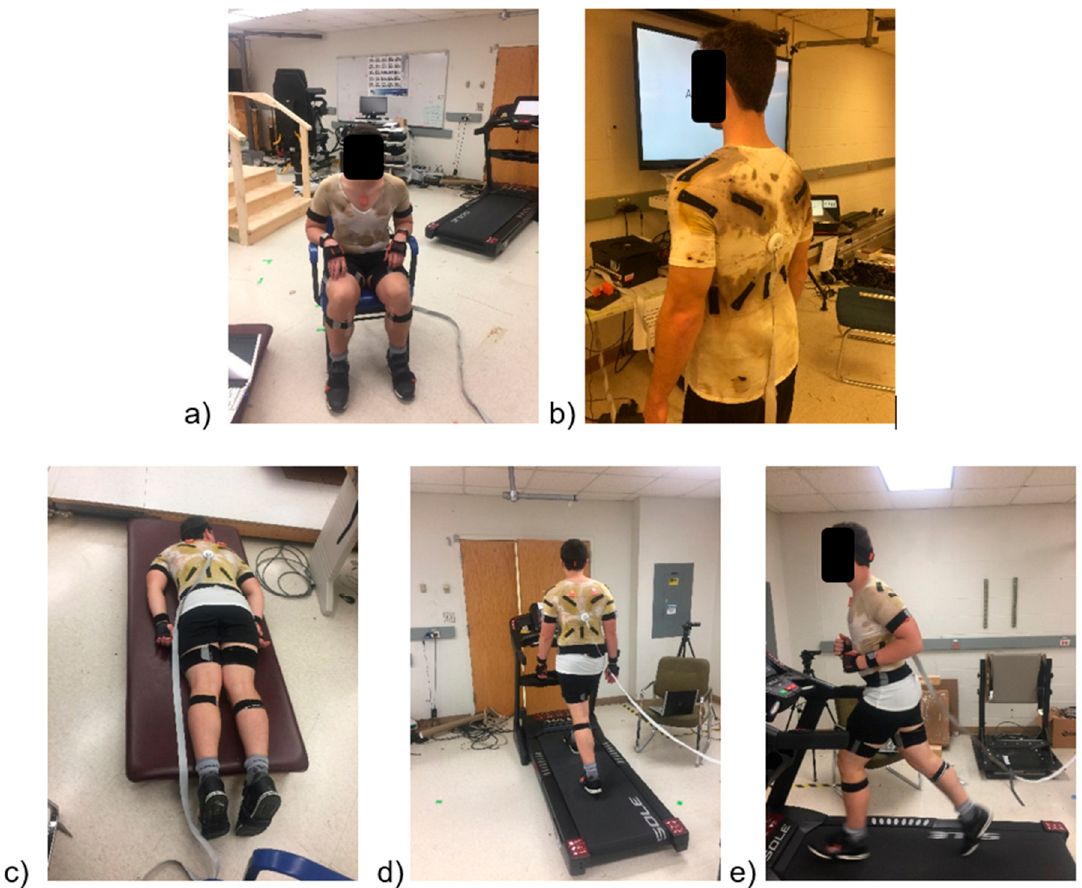
Figure 1. Illustrations of a participant wearing two smart garments (smart shirt and smart socks) while: ( a ) A5: sitting, ( b ) A3: standing, ( c ) A2: lying down, ( d ) A6: walking, and ( e ) A9: running.